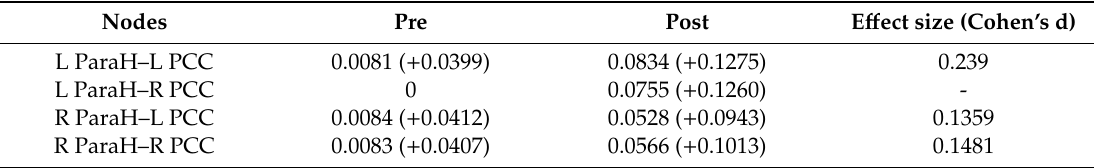
Table 4. E ff ect size (Cohen’s d) for significant clusters within the alpha band for the SM session. Left parahippocampal (L ParaH), right parahippocampal (R ParaH), left posterior cingulate cortex (L PCC), and right posterior cingulate cortex (R